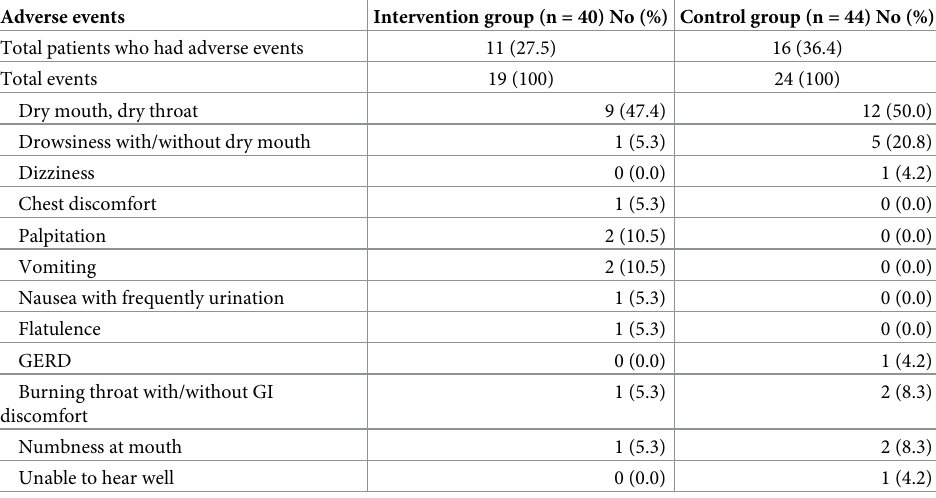
Table 6. Adverse drug reactions (ADR) reported in the intervention and control